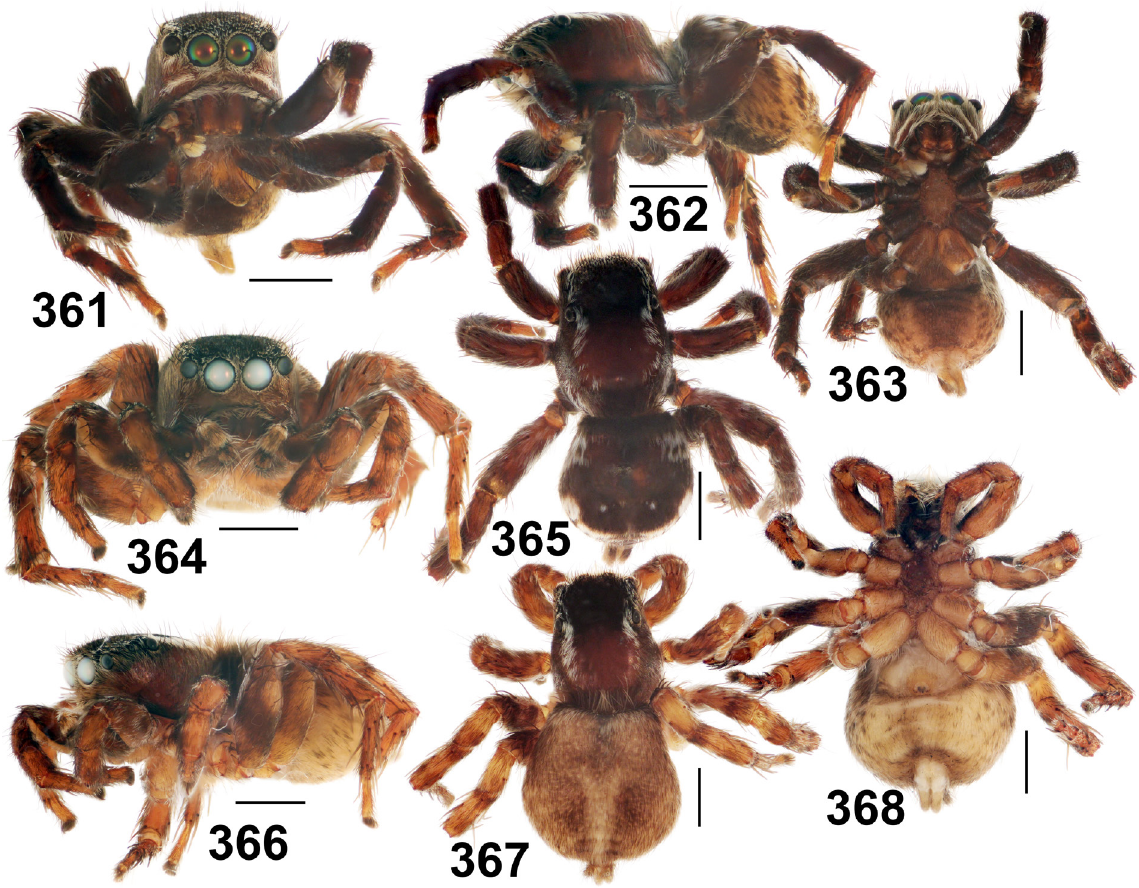
Figs 361–368. Stenaelurillus modestus Wesołowska, 2014, from South Africa (uMkhuze GR),